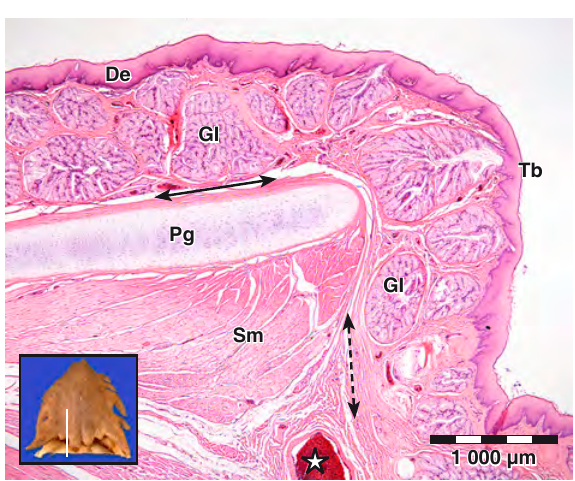
FIG. 11 Longitudinal section of the caudal tongue body. The paraglossum (Pg) forms the core between the connec­ tive tissue layer (lingual submucosa) filled with large, simple branched tubular glands (Gl). Note the large amount of skeletal muscle (Sm) attaching at the base of the paraglossum . Tongue base (Tb), dorsal epitheli­ um (De), compressed submucosa dorsal to the para­ glossum (double­headed arrow) and surrounding the skeletal muscle (dotted double­headed arrow), large blood vessel (white star)